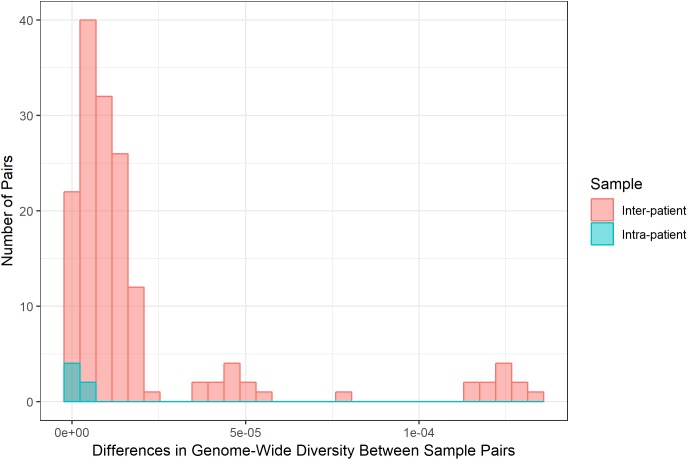
Differences in bacterial diversity among inter-patient and intra-patient pairs of samples. Frequency (y-axis) of absolute difference in genome-wide nucleotide diversity (average π across sliding windows, x-axis) between samples. We calculated the absolute difference in genome-wide π for all possible pairs of sputum samples and all possible pairs of culture samples for inter- and intra-patient samples (sputum versus sputum and culture versus culture). Inter- and intra-patient differences pictured in coral and teal, respectively. Differences among samples from the same patient are similar to the bulk of comparisons between patients. Some between-patient pairs exhibit extreme differences in diversity.